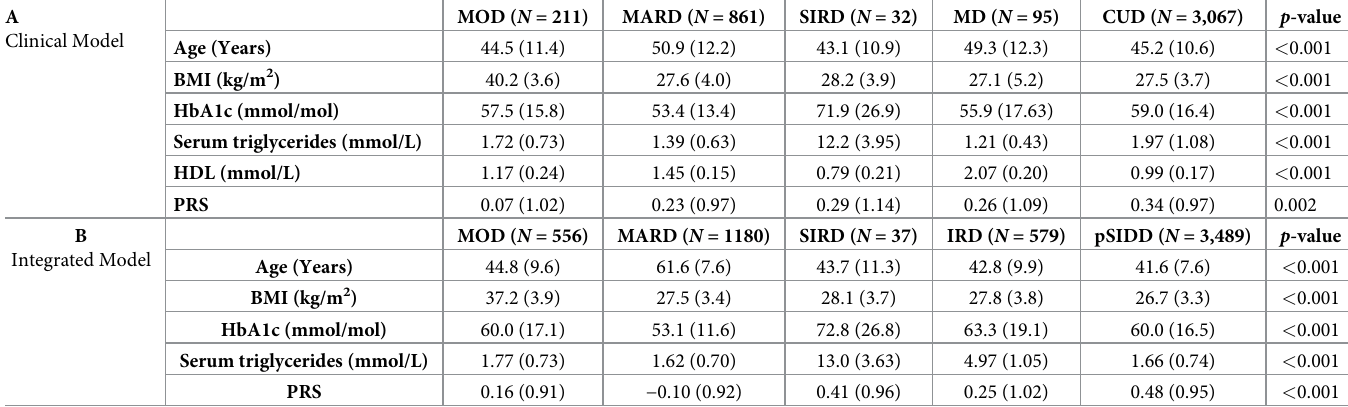
Fig 5. Cluster analysis using clinical variables at T2D diagnosis with and without PRS. Radar plots showing cluster mean values of the variables used to derive 5 clusters of individuals with T2D at the time of diagnosis in 2 separate models. In panel A (Clinical Model), latent class analysis was performed using age, BMI, HbA1c, serum triglycerides, and HDL. In panel B (integrated model), clustering was repeated using T2D PRS in place of HDL. The centre and edge of each polygon represent the minimum and maximum mean cluster values for each variable, respectively. All polygons represent the same scale; all scales are linear. Mean values for each variable within each cluster are represented by coloured dots. For example, mean BMI is highest in cluster 1. BMI, body mass index; HbA1c, hemoglobin A1c; HDL, high-density lipoprotein; PRS, polygenic risk score; T2D, type 2 diabetes. https://doi.org/10.1371/journal.pmed.1003981.g005 Table 2. Clinical and Integrated cluster